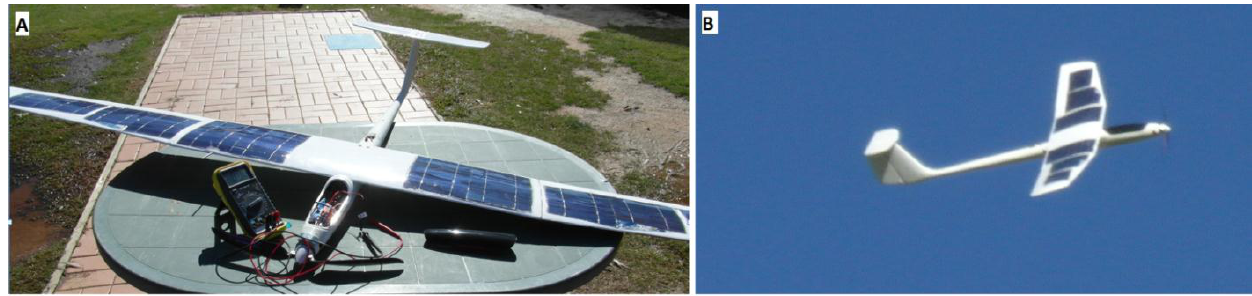
Figure 15. Monitoring of atmospheric CO 2 integrating two ground nodes and one aerial node.